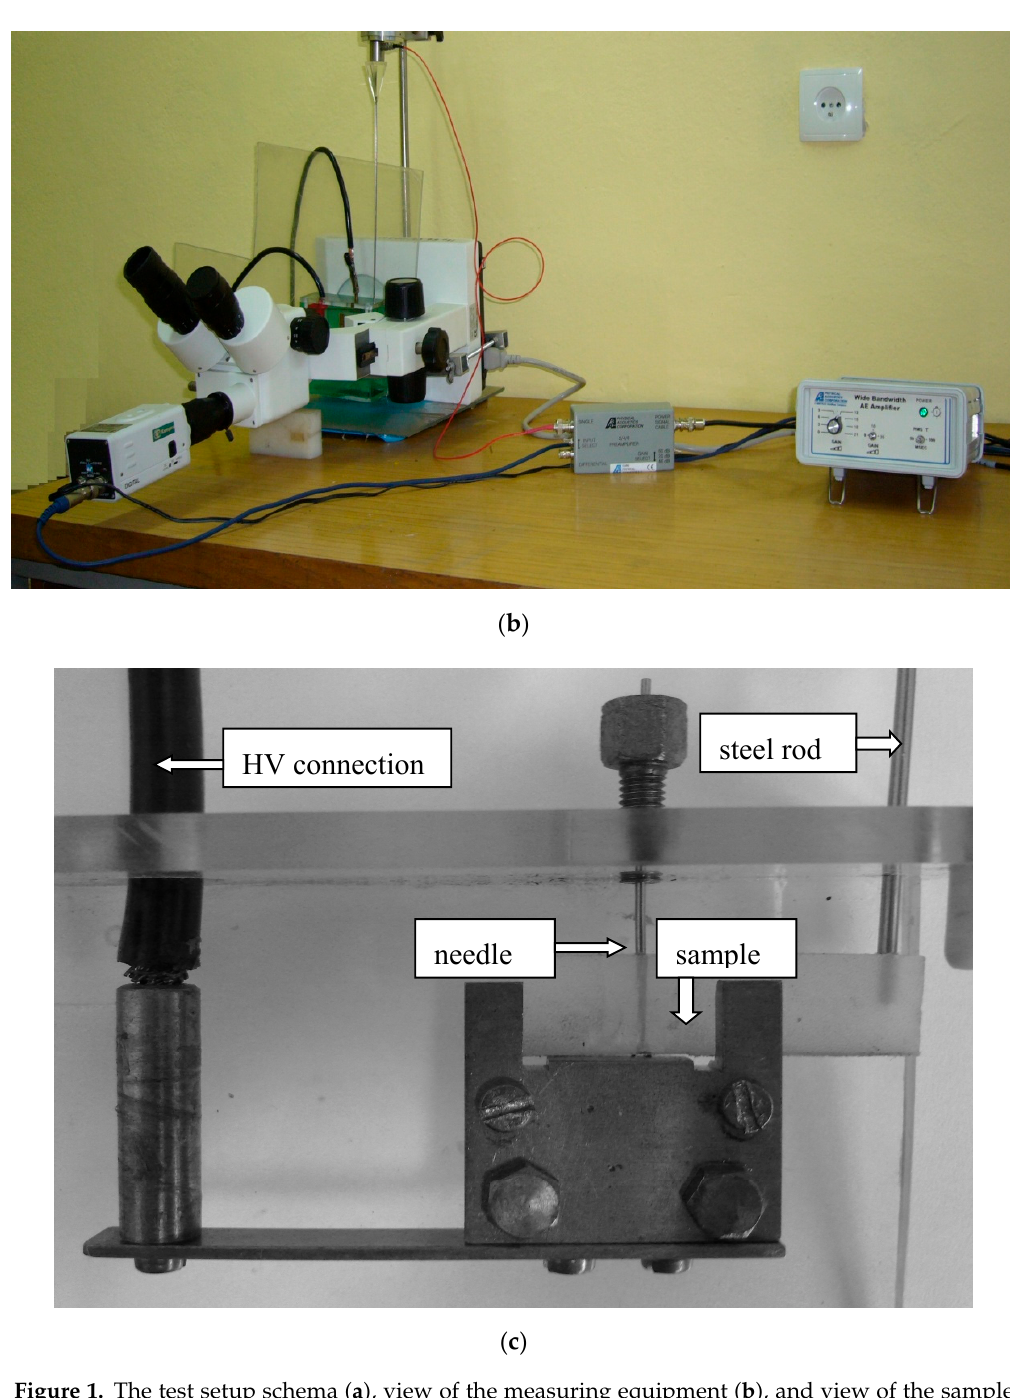
Figure 1. The test setup schema ( a ), view of the measuring equipment ( b ), and view of the sample holder ( c ) for measuring acoustic signals accompanying the treeing of solid dielectrics.